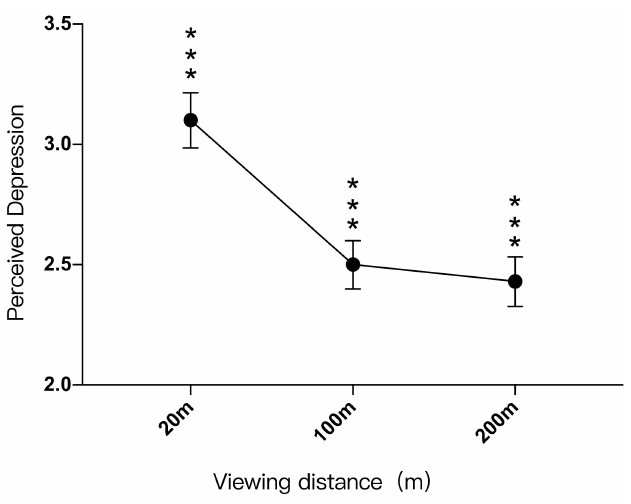
Figure 9. Impacts of different viewing distances on perceived depression, ***: p <